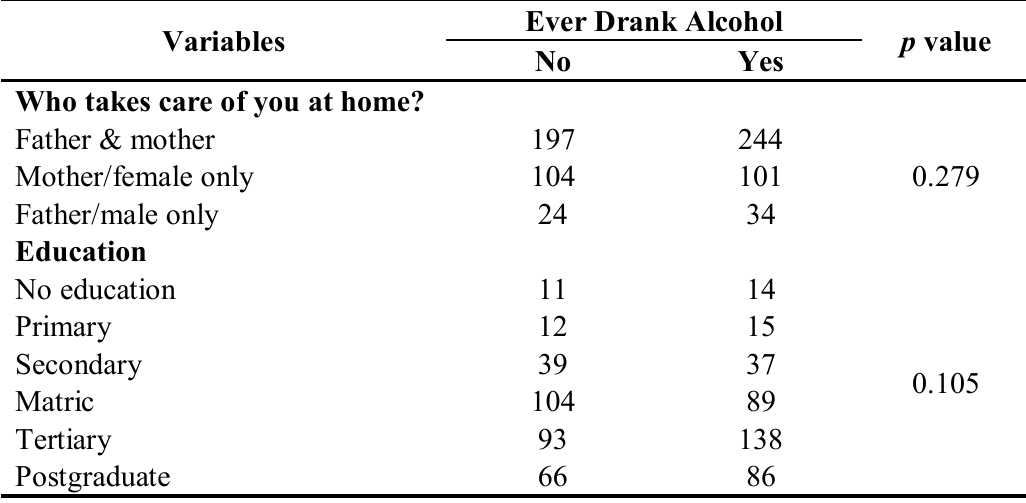
Table 2. Caregivers socio-demographic information in relation to adolescents alcohol